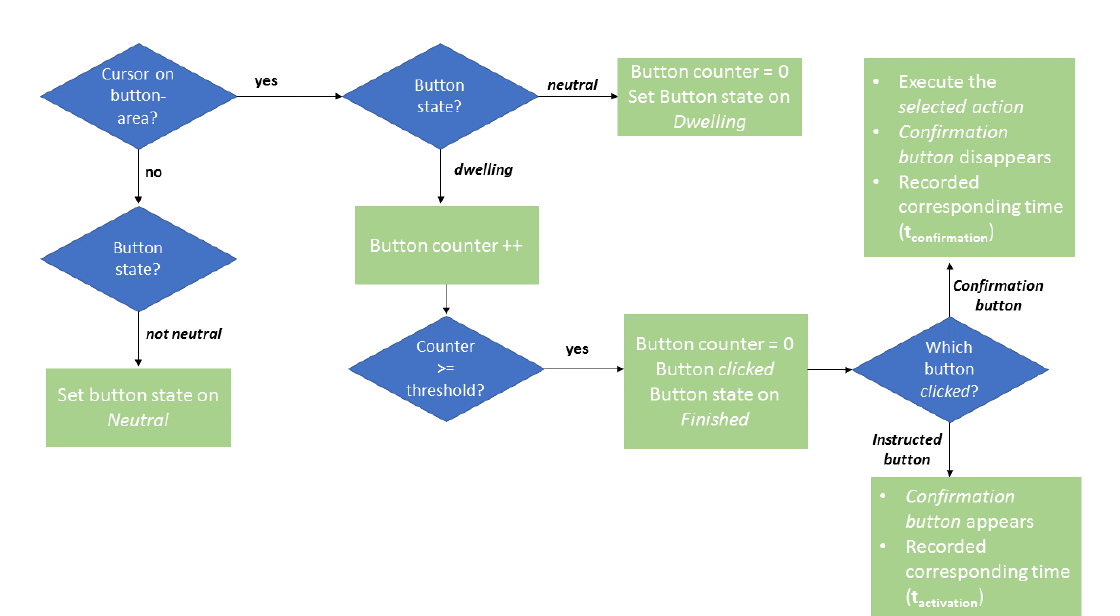
Figure 2. Flowchart of the Dwell button implementation in the GUI used for the Activation of Buttons Test and the Use-Case Test